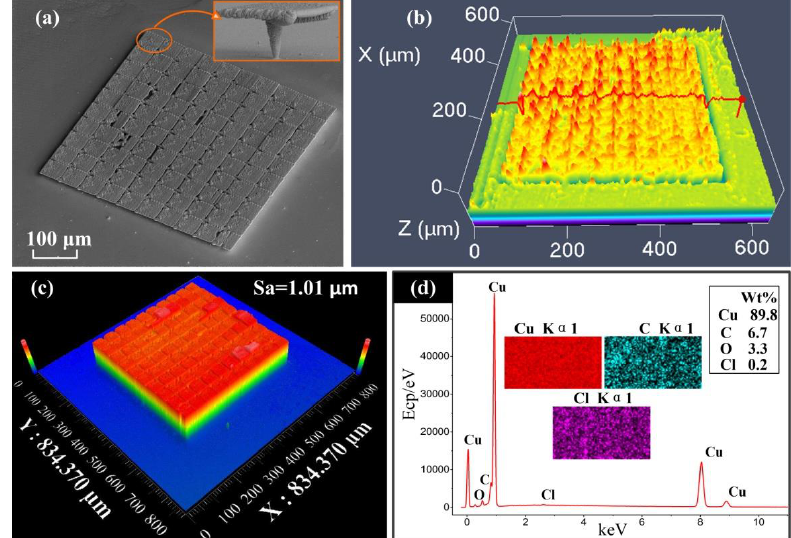
Figure 6. Production of large-area suspended surface. ( a ) SEM image of suspended planar array pattern, forming a 10 × 10 array structure, printing a large-area additive manufacturing surface of 400 μm × 400 μm, a single structure size of 40 μm × 40 μm. ( b ) Using laser scanning confocal microscopy to characterize the surface of the array pattern, protrusions appeared at the position where the small surface was spliced to the next surface, resulting in a very uneven surface. ( c ) The white light interferometer measures the macroscopic topography of the array plane. The top surface of the topography is suspended, and the upper surface is only a thin layer. So, the edges of the overall structure are neat. Additionally, the measured surface roughness value Sa = 1.01 μm. ( d ) The chemical element analysis by EDS based on the SEM. Additionally, the surface of the deposit contains elements of Cu, C, O, and Cl.